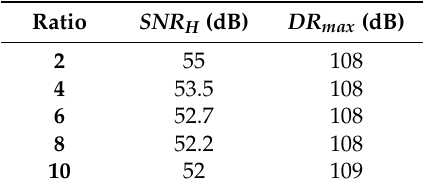
Table 3. Measured SNR H and DR max for a three exposures scenario and K = 1 with different exposure ratios of 2 (0.1 µ s, 0.2 µ s and 0.4 µ s), 4 (0.1 µ s, 0.4 µ s and 1.6 µ s), 6 (0.1 µ s, 0.6 µ s and 3.6 µ s) and 8